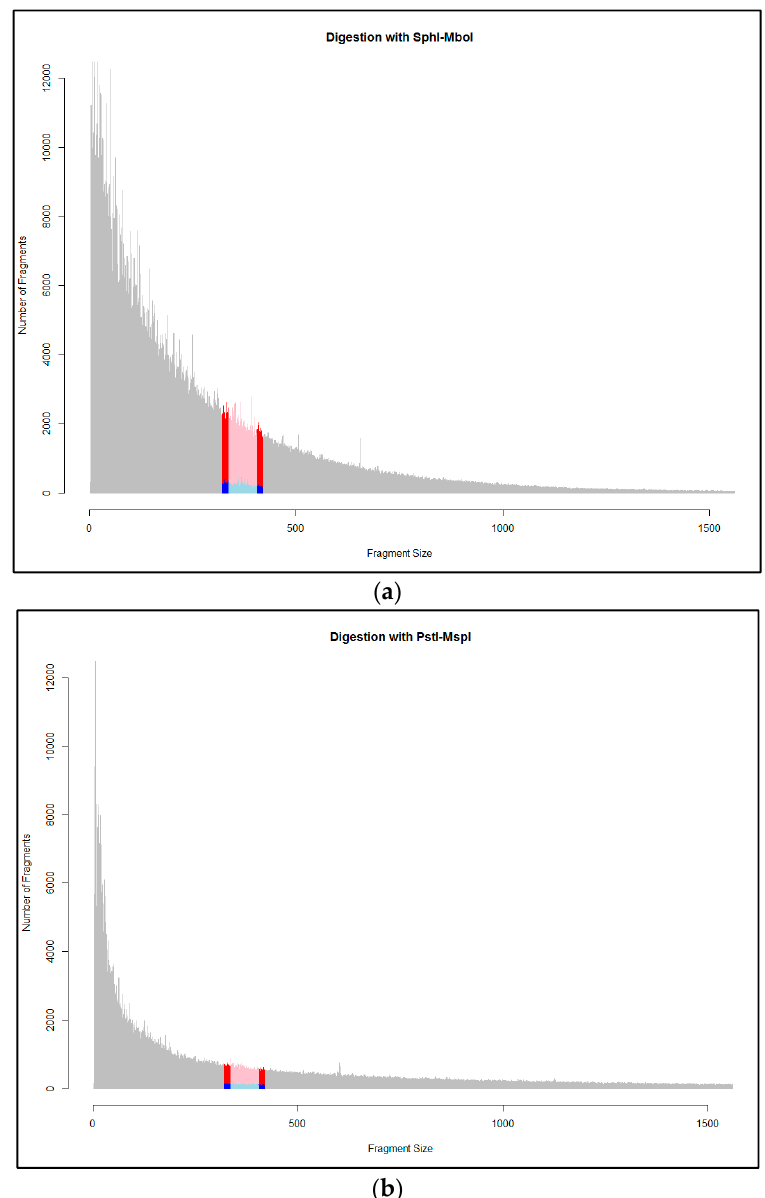
Figure 2. Histograms of in silico simulations (frequency versus fragment size). ( a ) In silico digestion with SphI-MboI. ( b ) In silico digestion with PstI-MspI. Total fragments obtained in digestion (grey); subpopulation of fragments obtained by manual size selection (the whole colored area); subpopulation of fragments obtained by automatic size selection (pink + light blue area); and subpopulation of AB + BA fragments selected, amplified and sequenced (manual: blue + light blue areas; automatic: light blue